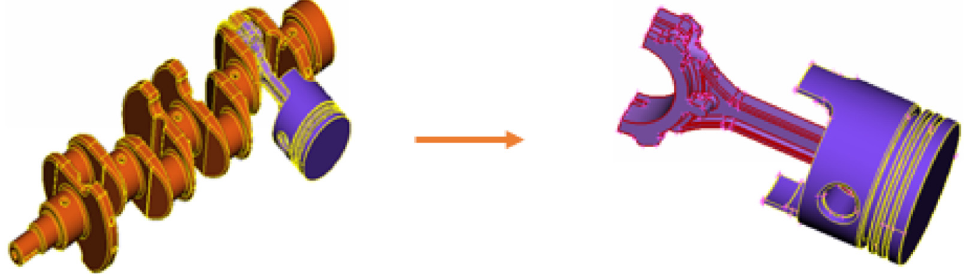
Fig. 7. Script output with R-Tree approach to identify nearest part.